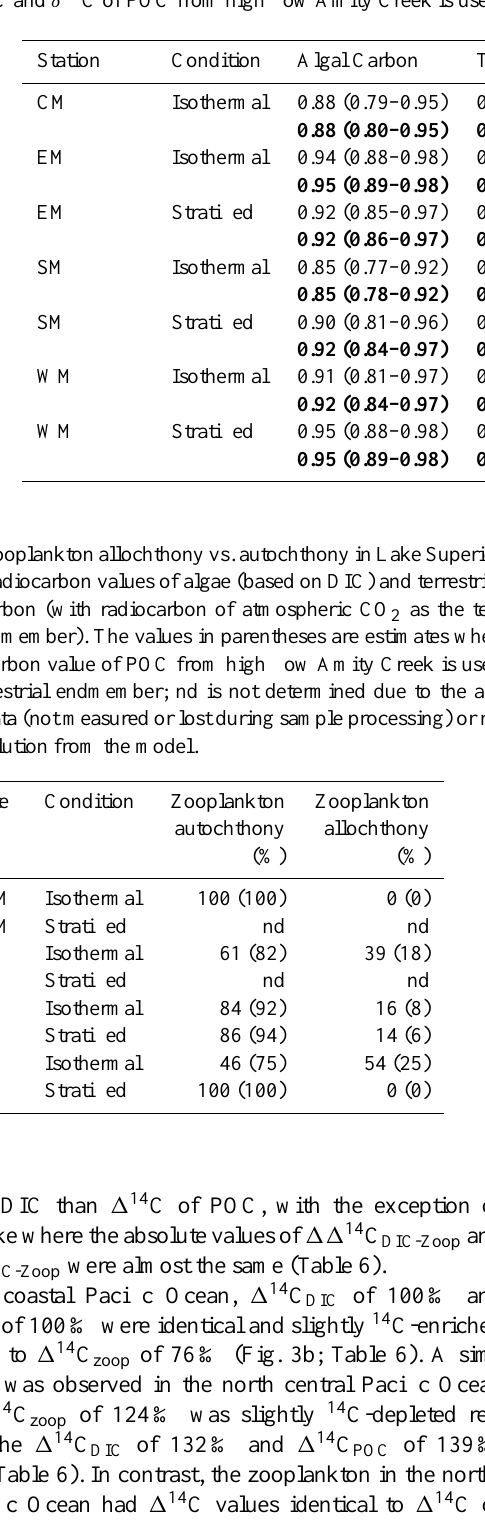
Table 4. Proportional median contribution of putative food sources to zooplankton biomass in Lake Superior. The Bayesian MixSIR model was used in computing these values using algal carbon from recent photosynthesis, terrestrial POC, sedimentary carbon, and bacterial biomass as food options (as described in Sect. 2.4.1). The values in parentheses are the 5% and 95% confidence percentiles. As in Table 3, the regular values are model estimates when 1 14 C of corn leaves and δ 13 C of terrigenous POC are used as the terrestrial endmember; bold values are when 1 14 C and δ 13 C of POC from high flow Amity Creek is used as the terrestrial endmember.